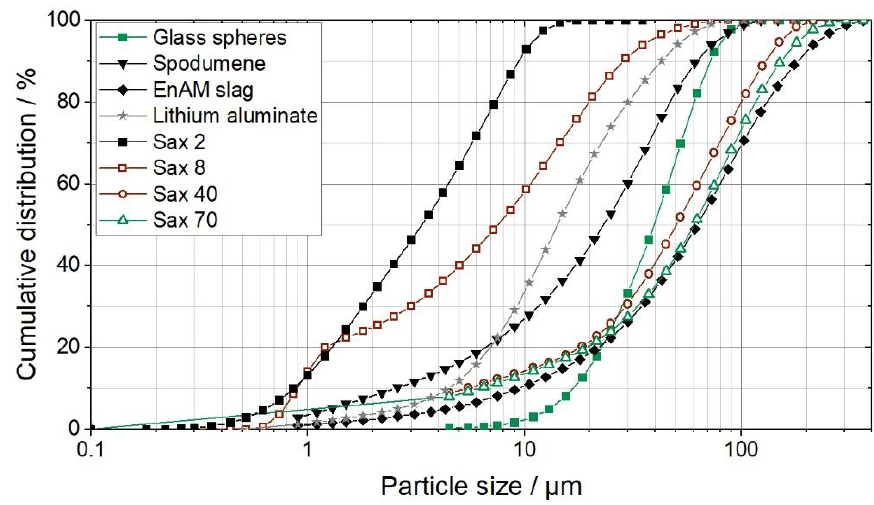
Figure 2. Cumulative particle size distributions (Q 3 ) of the used materials obtained with laser diffraction.